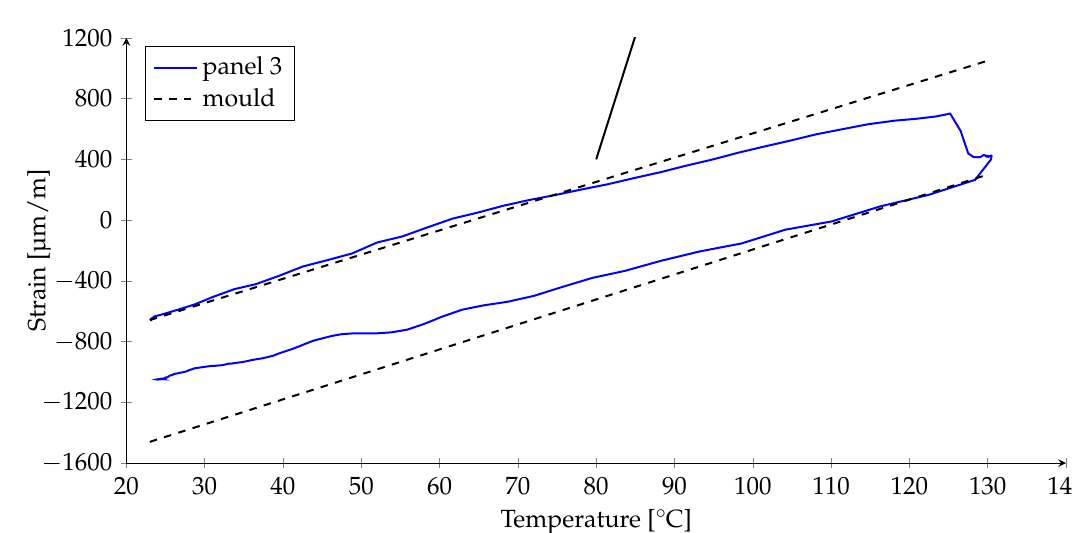
Figure 8. Measured strain of panel 3 in dependency on the temperature during the post-curing